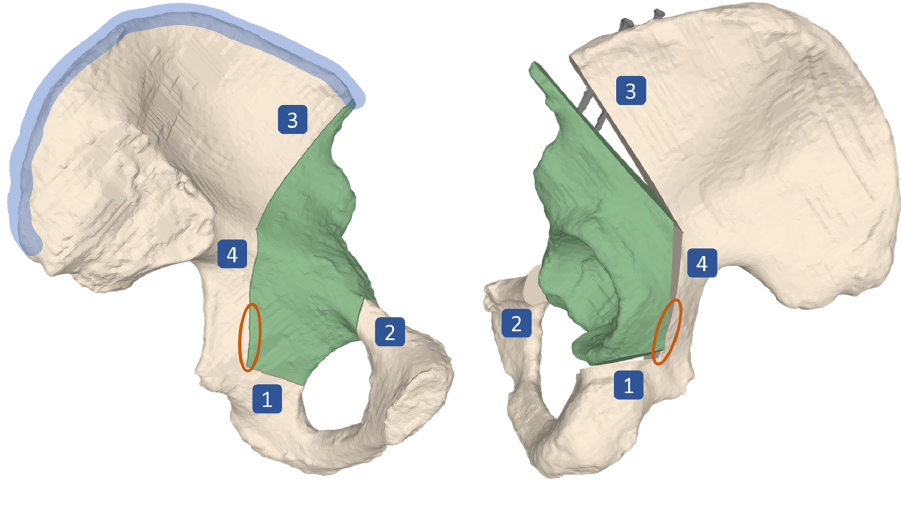
Figure 1. Surgical technique of periacetabular osteotomy of Ganz (PAO). Four osteotomies, namely the ischial (1), pubic (2), supra- (3) and retroacetabular (4) are performed, followed by a controlled fracture (area marked in orange), which mobilizes the acetabular fragment (green). The fragment is then reoriented in space before it is fixed to the remaining pelvis by two screws (shown in gray) at its target position. The area marked in blue is called the iliac crest. Left: lateral view on the pelvis, preoperatively. Right: Medial view on the pelvis,